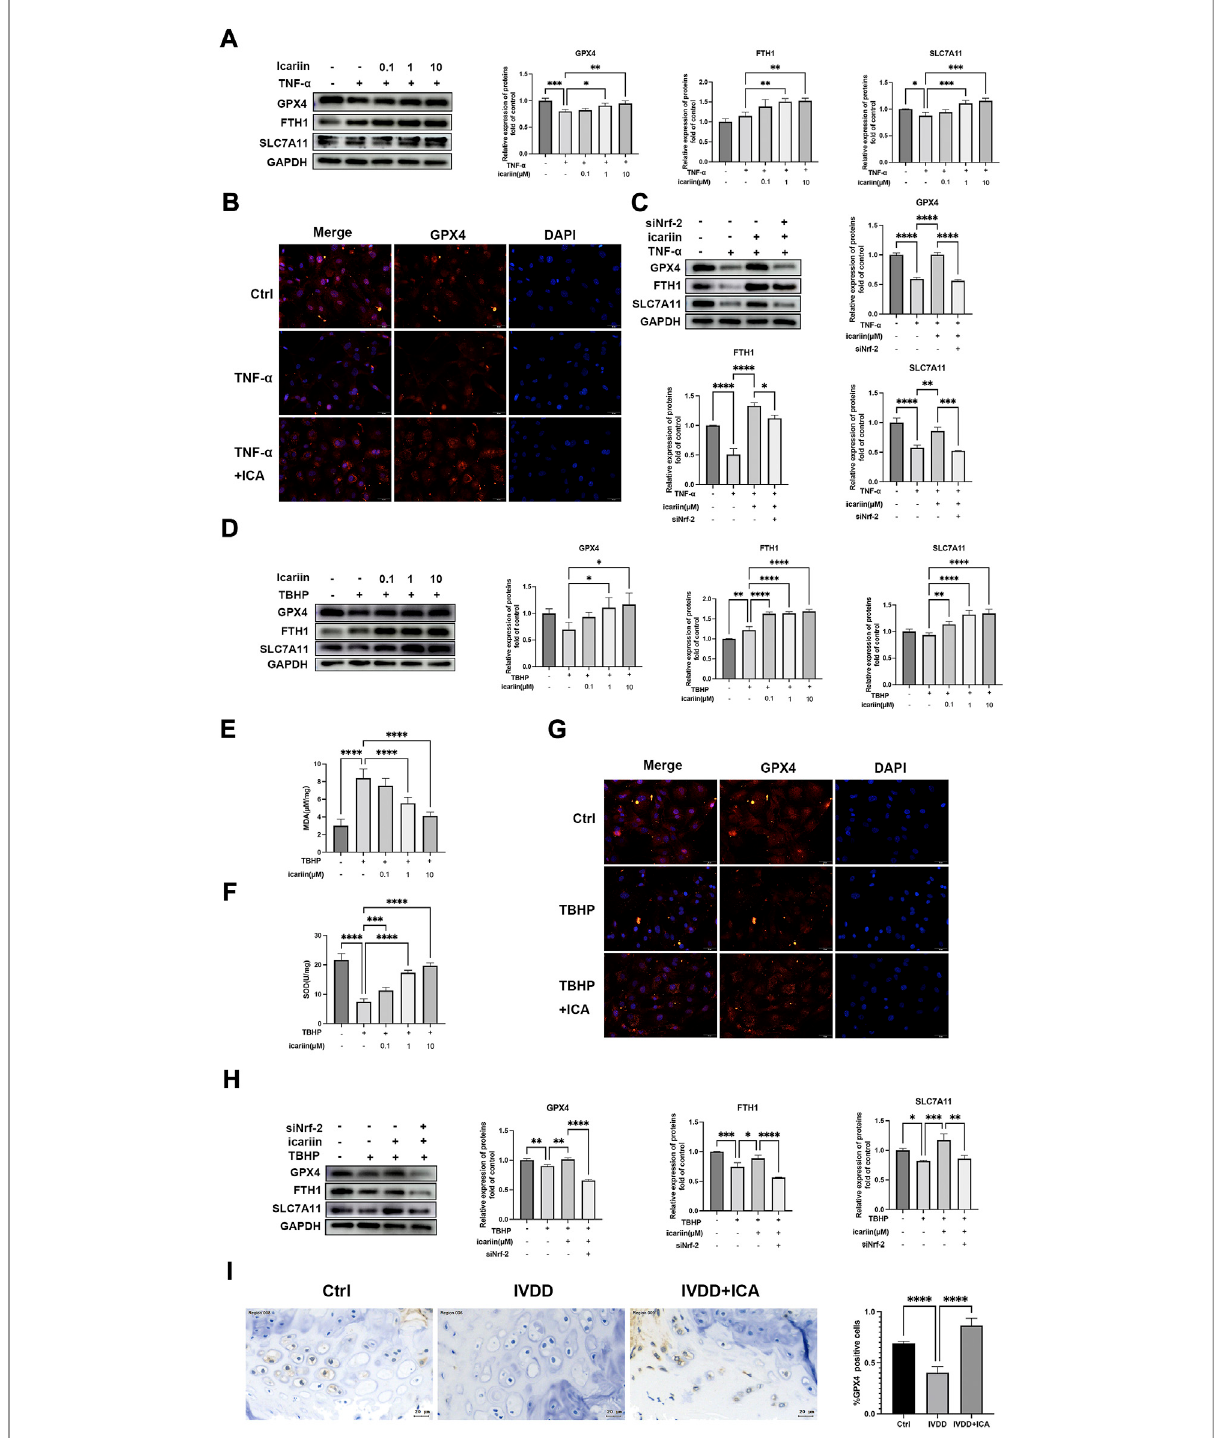
FIGURE 7 ICA inhibited endplate chondrocyte ferroptosis under pathological conditions via activating Nrf-2. (A) Chondrocytes were treated with TNF- α (5 ng/ml) and ICA (0.1, 1, 10 μ M) for 24 h, and Western blot was conducted to examine the protein levels of GPX4, FTH1, and SLC7A11. The band densities of GPX4, FTH1, and SLC7A11 were quanti fi ed and normalized to control. (B) Chondrocytes were treated with TNF- α (5 ng/ml) with or withoutICA(10 μ M)for24 h,andimmuno fl uorescencestainingwasconductedtoexaminetheexpressionandlocalizationofGPX4.Scalebar= 20 µm. (C) Chondrocytes were transfected with Nrf-2 siRNA, then treated with TNF- α and ICA for 24 h. Protein levels of GPX4, FTH1, and SLC7A11 were determined by Western blot. The band density was quanti fi ed and normalized to control. (D) Chondrocytes were treated with TBHP